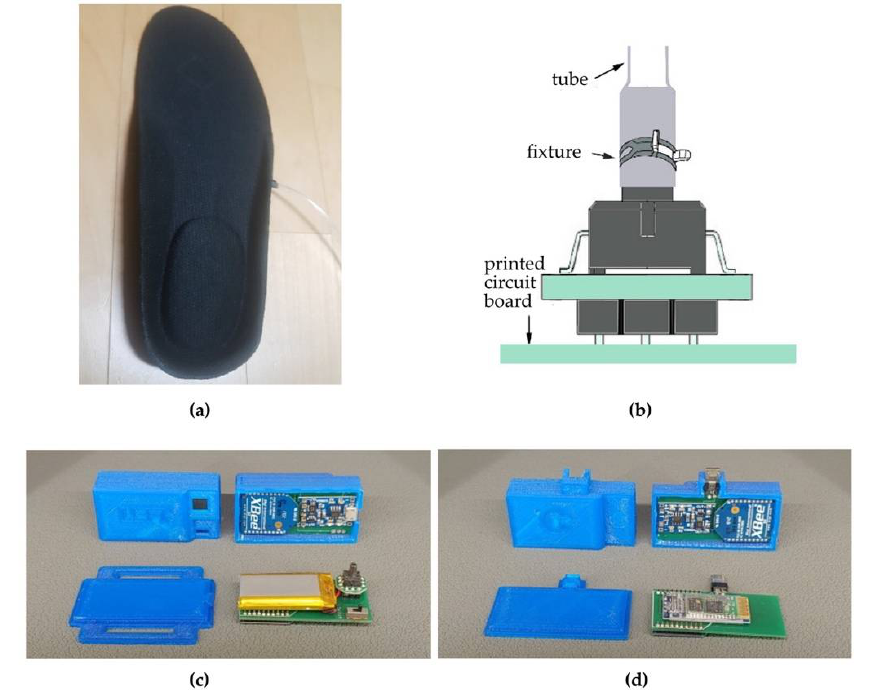
Figure 2. The custom-made air insole: ( a ) Air cap insole; ( b ) Pneumatic-pressor sensor. ( c ) Peripheral unit; ( d ) central unit.